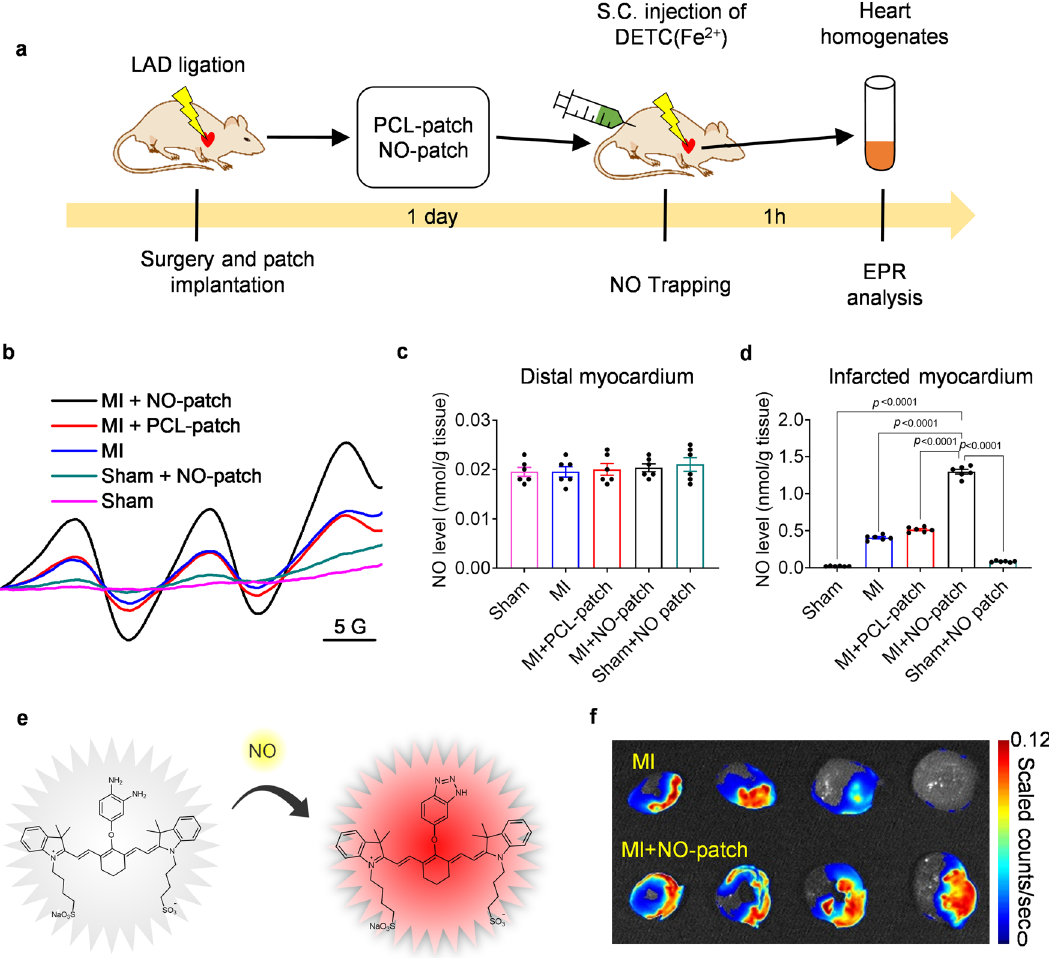
Fig. 2 Enhanced NO generation in the infarcted myocardium because of hypoxic and acidic microenvironments. a – d NO-patch was applied for the treatment of MI in rats, and NO accumulation in the myocardium was measured by EPR assay. One day after surgery, cardiac tissues were collected and divided into infarcted part and distal part, which were subjected to EPR analysis, respectively. a Schematic illustration of EPR analyses. b Representative EPR spectra re fl ecting NO generation in the infarcted myocardium in the presence of (DETC) 2 Fe. NO levels in the distal ( c ) and infarcted ( d ) myocardium were determined by quantitation of (DETC) 2 Fe – NO complex using 2,2,5,5-tetramethyl piperidine 1-oxyl (TEMPO). Data are expressed as mean ± SEM, n = 6 animals for each group. Signi fi cant differences were detected by two-tailed one-way ANOVA with Tukey ’ s multiple comparisons test. e , f NO accumulation in the myocardium was detected by imaging of the infracted myocardium with NO-sensitive fl uorescent probe. The principle for the detection of NO by the probe was shown in ( e ). The probe DAC-S was non- fl uorescent; NO induced a signi fi cant fl uorescence turn-on response at 805 nm. Representative NIR fl uorescence images of infarcted myocardium in different locations were shown in ( f ). LAD: left anterior descending artery; EPR: electron paramagnetic resonance; DETC(Fe 2 + ): ferrous N-diethyl dithiocarbamate; NO: Nitric